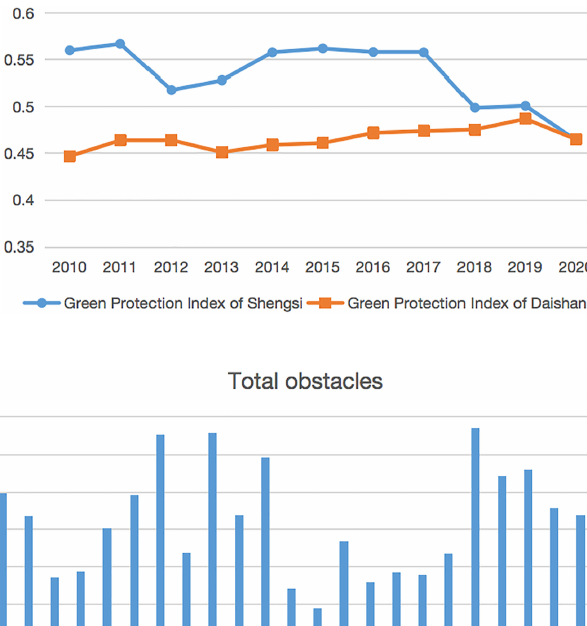
Figure 6. The calculation